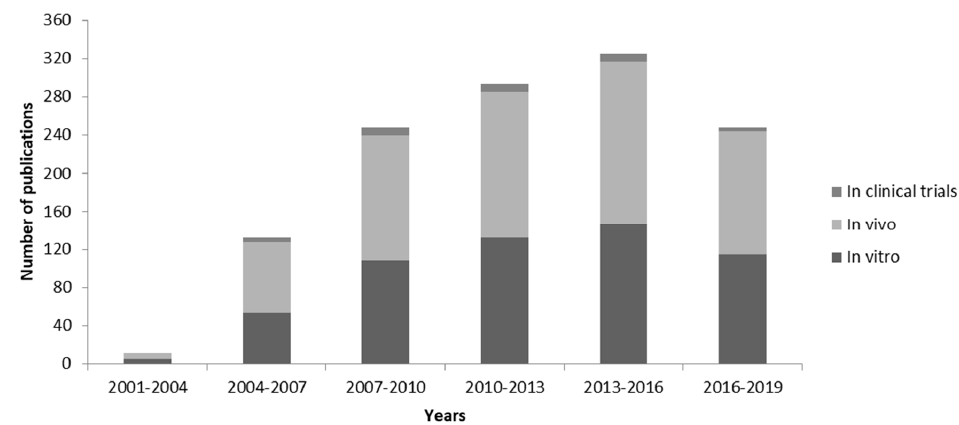
Figure 5. PubMed publications related to “siRNA liposome”. Data recorded in the PubMed database were identified with the search terms “ siRNA liposome ” and “ in vitro” or “ in vivo” or “ in clinical trials ” used for the search query. Data were compiled and plotted as a bar graph for the number of publications since 2001 and every three years; data for 2019 are based on the first five months.